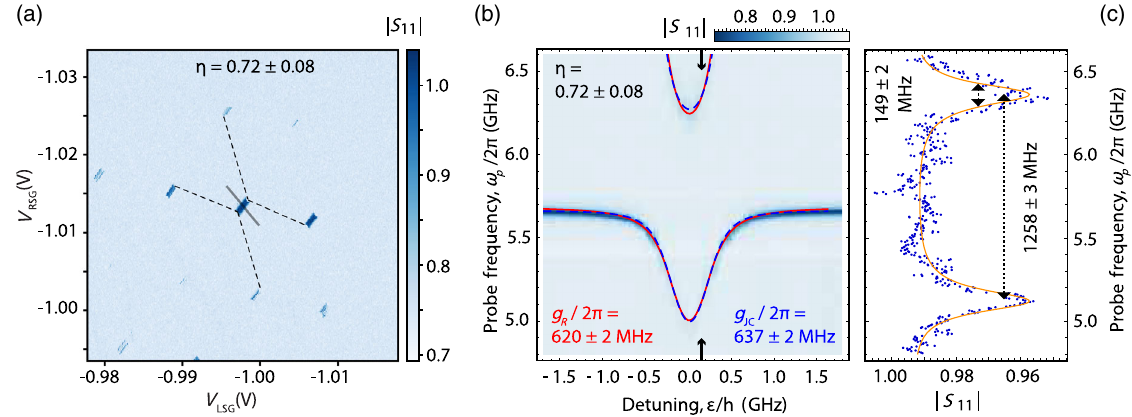
FIG. 5. Investigation of a bias configuration approaching the ultrastrong-coupling regime for a DQD coupled to a JJ array resonator. (a) Charge stability diagram of the DQD measured by monitoring the change in resonator reflectance amplitude j S 11 j for the extracted dipole strength η ¼ 0 . 72 (cid:3) 0 . 08 . (b) Resonator amplitude response j S 11 j taken by varying the DQD detuning ϵ along the gray line indicated in (a) by applying appropriately chosen voltages to the two side gates. The red (blue) line represents a fit to the Rabi (JC) model (see Appendix F). (c) Measured resonator reflectance j S 11 j (dots) versus probe frequency ω extracted at resonance for ϵ =h ¼ 0 . 15 GHz p [black arrows in (b)], displaying a vacuum Rabi mode splitting. The orange line represents a fit to a Rabi master equation model. The JJ = 2 π ¼ 19 . 5 (cid:3) 0 . 1 MHz and κ = 2 π ¼ 5 . 7 (cid:3) 0 . 1 array resonator losses are κ int ext